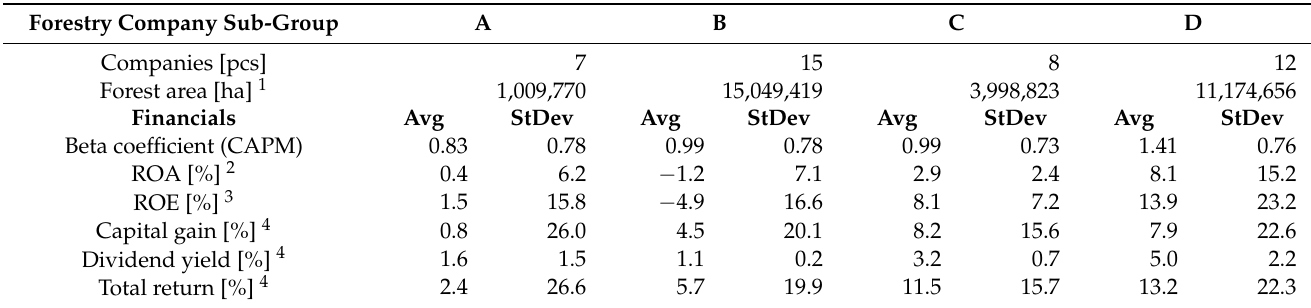
Table 3. Forestry companies’ sub-groups and their investment characteristics.